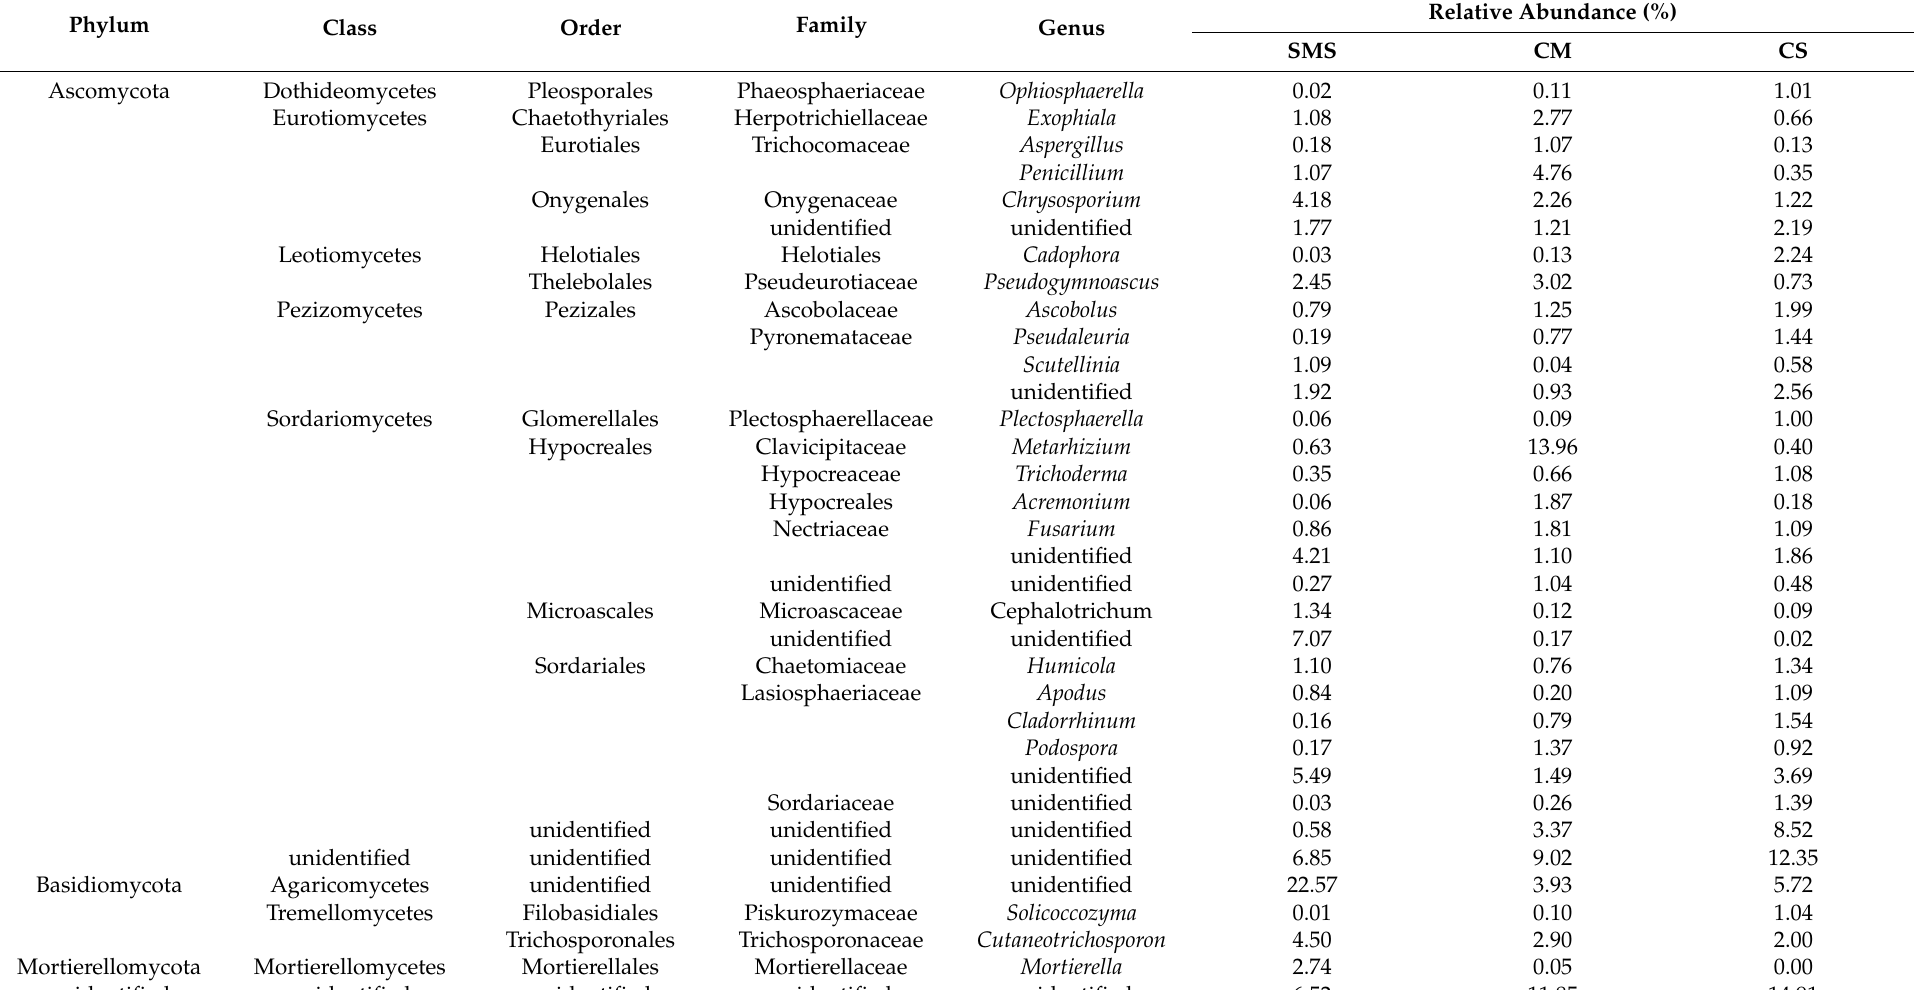
Table 3. The relative abundance of the phylogenetic genus in the different amended soils, according to its relative abundance ( ≥ 1%) in each treatment.